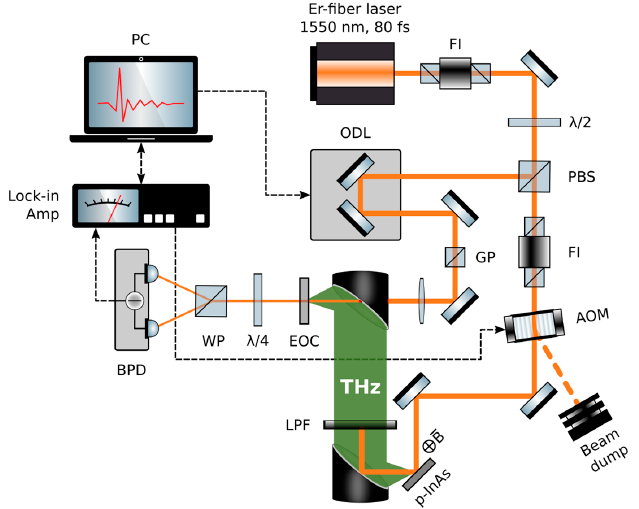
Figure 4. Layout of the experimental setup—terahertz time-domain spectrometer. FI—Faraday isolator, λ /2—half-wave plate, PBS—polarization beamsplitter, ODL—optical delay line, GP—Glan polarizer, AOM—acousto-optical modulator, LPF—low-pass filter, THz—terahertz radiation, EOC—electro-optic crystal, λ /4—quarter-wave plate, WP—Wollaston prism, BPD—balanced photodetector, PC—personal computer.